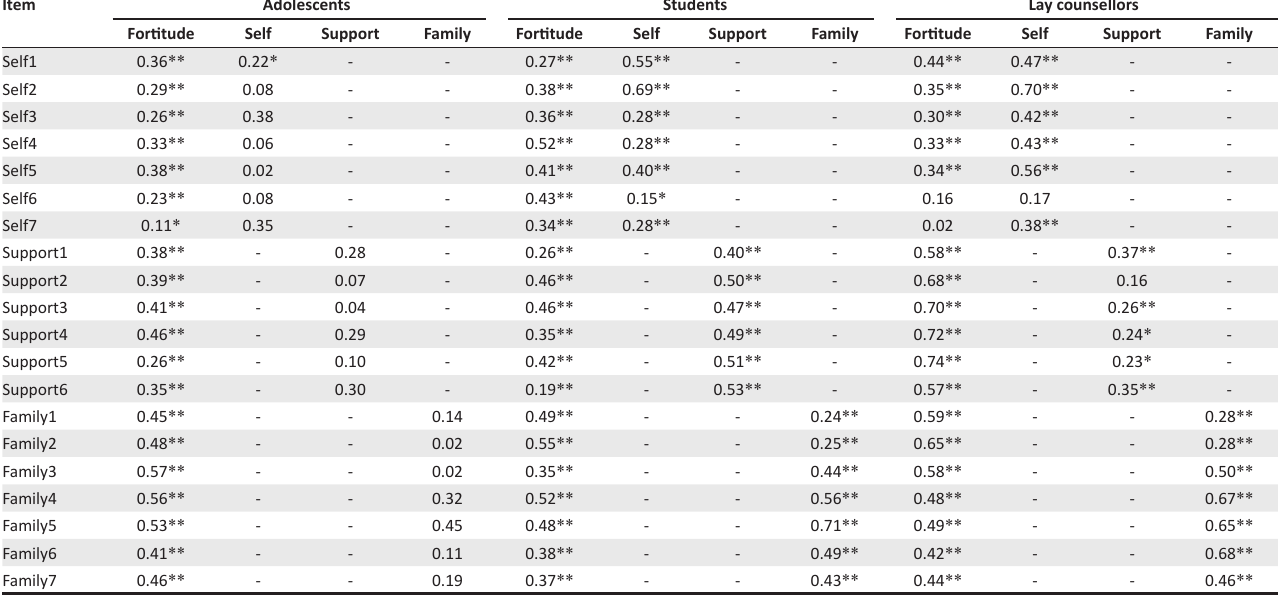
TABLE 2: Standardised solution for the Fortitude Questionnaire in the three samples. Item